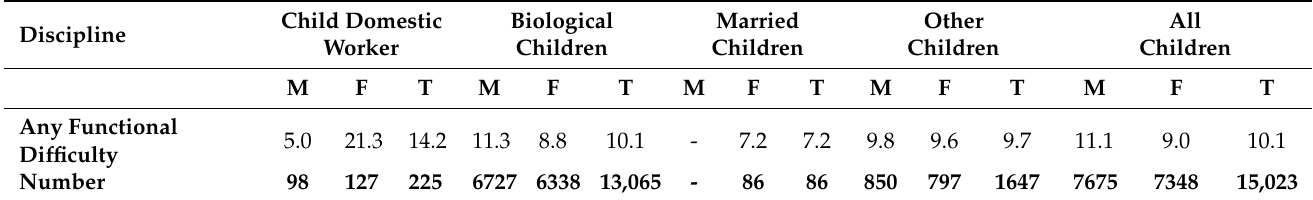
Table 8. Proportion of children with Functional Difficulties by sex ( N = 15,023, %).